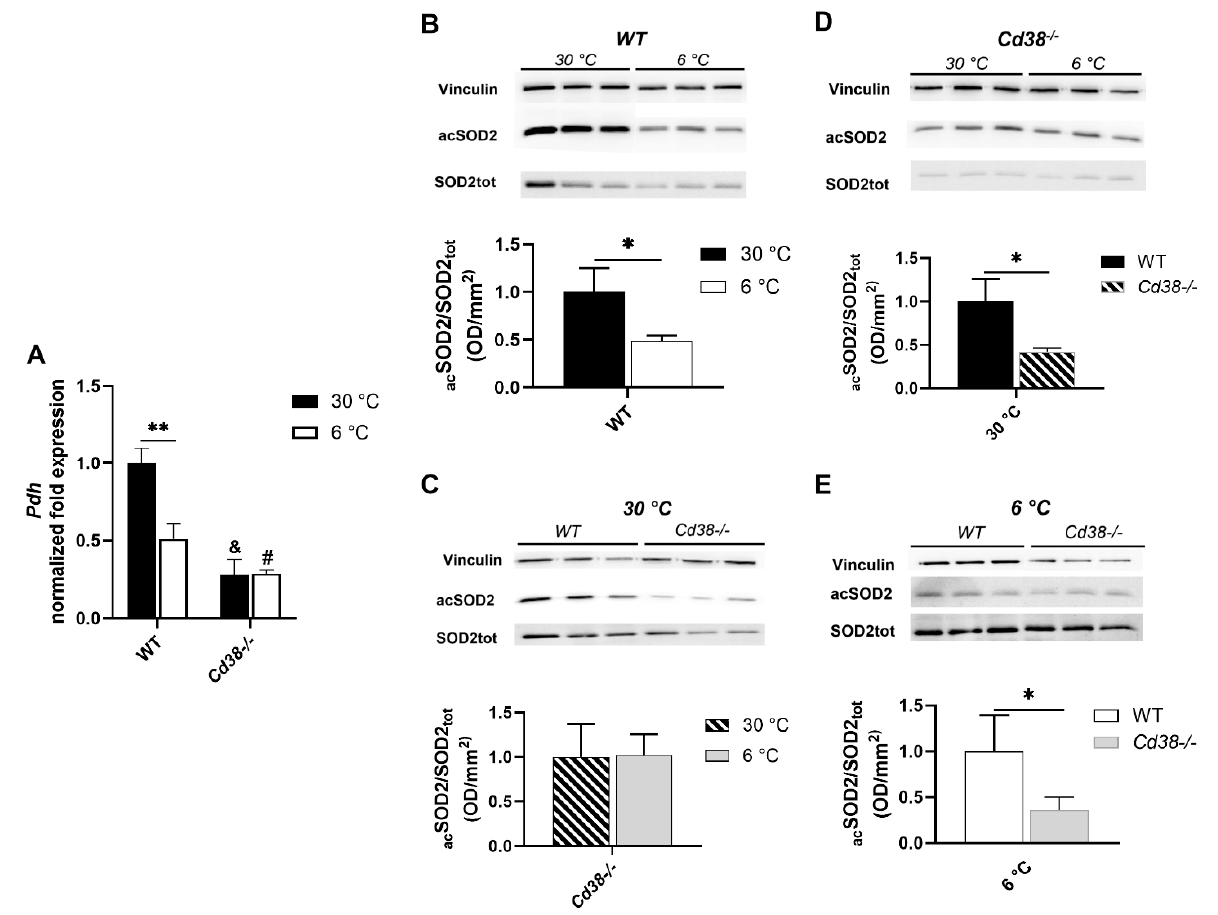
Figure 5. Cold exposure SIRT3 activity in WT, but not in Cd38 − / − mice, with SIRT3 over-activated at warm temperatures in Cd38 − / − mice. Livers from WT and Cd38 − / − mice, kept for 1 week at 30 °C (black bars) or 6 days at 22 °C followed by 1 day at 6 °C (white bars), were used. Pdh expression was evaluated by RT-PCR ( A ). SIRT3 activity was evaluated by Western blot, measuring the acetylation level of SOD2, a substrate of SIRT3 activity ( B – E ). Results of quantification are the mean ± SD from